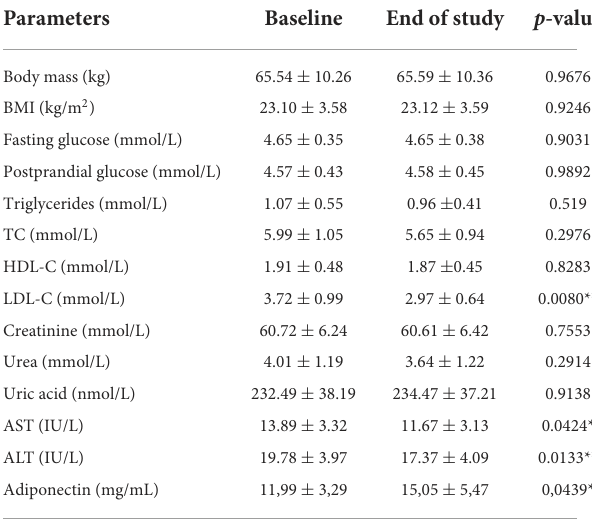
TABLE 1 Anthropometric characteristics and biochemical parameters of the study participants at baseline and after 4 week intervention.